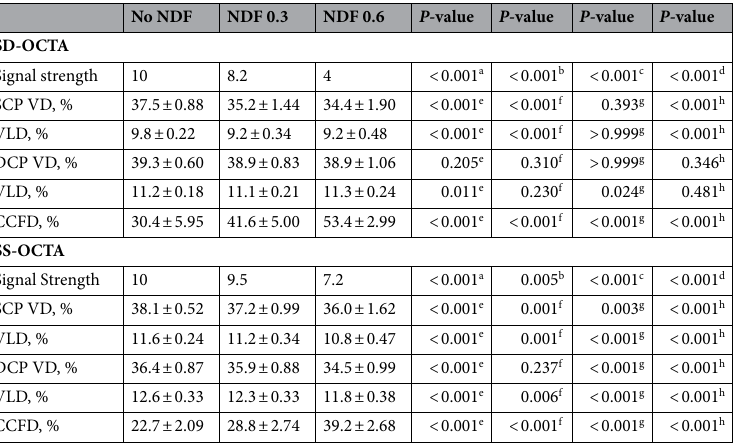
Table 1. The quantitative measurement of blood flow in the superficial capillary plexus, deep capillary plexus and choriocapillaris flow deficits according to the application of neutral density filter. CCFD choriocapillaris flow deficits, DCP deep capillary plexus, NDF neutral density filter, OCTA optical coherence tomography angiography, SCP superficial capillary plexus, SD spectral-domain, SS swept-source, VD vessel density, VLD vessel length density. a The p-value was obtained from the Friedman test. b The p-value was obtained from the Wilcoxon signed rank test with post-hoc test (Bonferroni) between no NDF and NDF 0.3 groups. c The p-value was obtained from the Wilcoxon signed rank test with post-hoc test (Bonferroni) between NDF 0.3 and NDF 0.6 groups. d The p-value was obtained from the Wilcoxon signed rank test with post-hoc test (Bonferroni) between no ND and NDF 0.6 groups. e The p-value was obtained from the one-way repeated measures analysis of variance. f The p-value was obtained from the post-hoc test (Bonferroni) between no NDF and NDF 0.3 groups. g The p-value was obtained from the post-hoc test (Bonferroni) between NDF 0.3 and 0.6 groups. h The p-value was obtained from the post-hoc test (Bonferroni) between no NDF and NDF 0.6